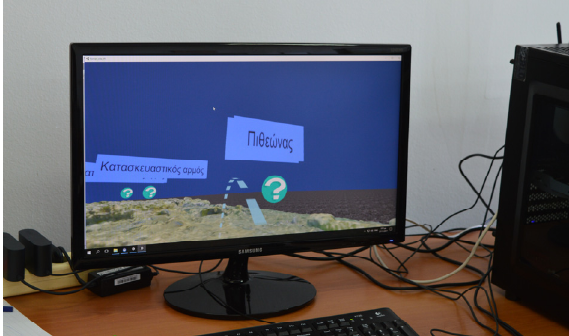
Figure 12: The signs indicating important parts of the villa in the virtual